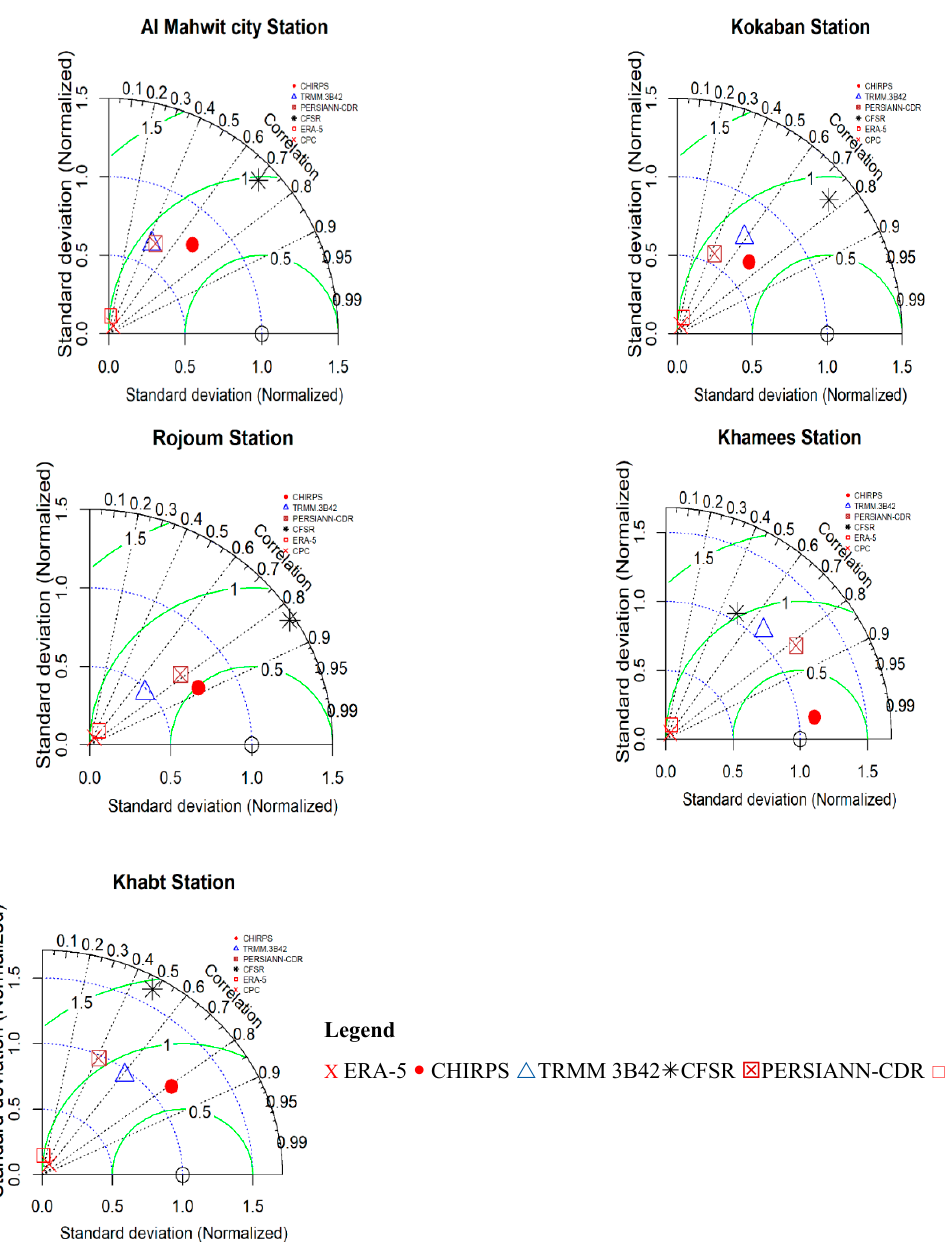
Figure 3. Summary of monthly correlation coefficient (r), root-mean-square error (RMSE, mm), and bias (BIAS, mm) of the precipitation products compared to observations in the five areas from Al Mahwit governorate: Khabt, Khamees, Kokaban, Mahwit city, and Rojom.